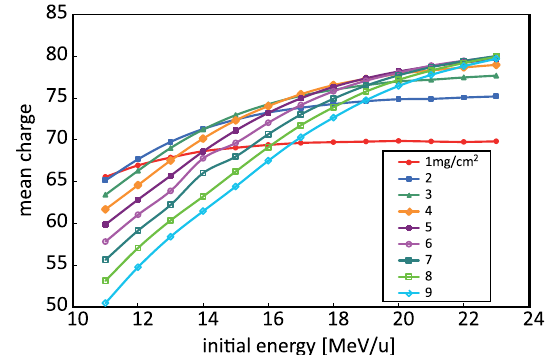
FIG. 11. Calculated dependence of the mean charge on the